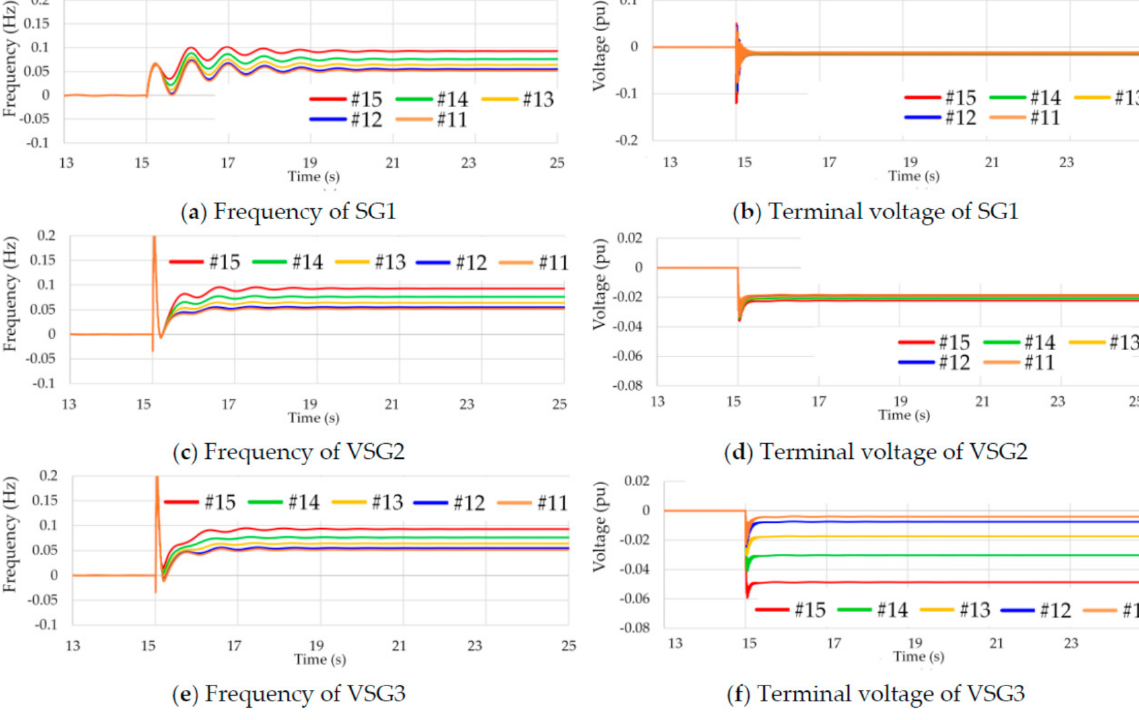
Figure 6. Transient responses of the frequency and voltage for tests 11–15 in Table